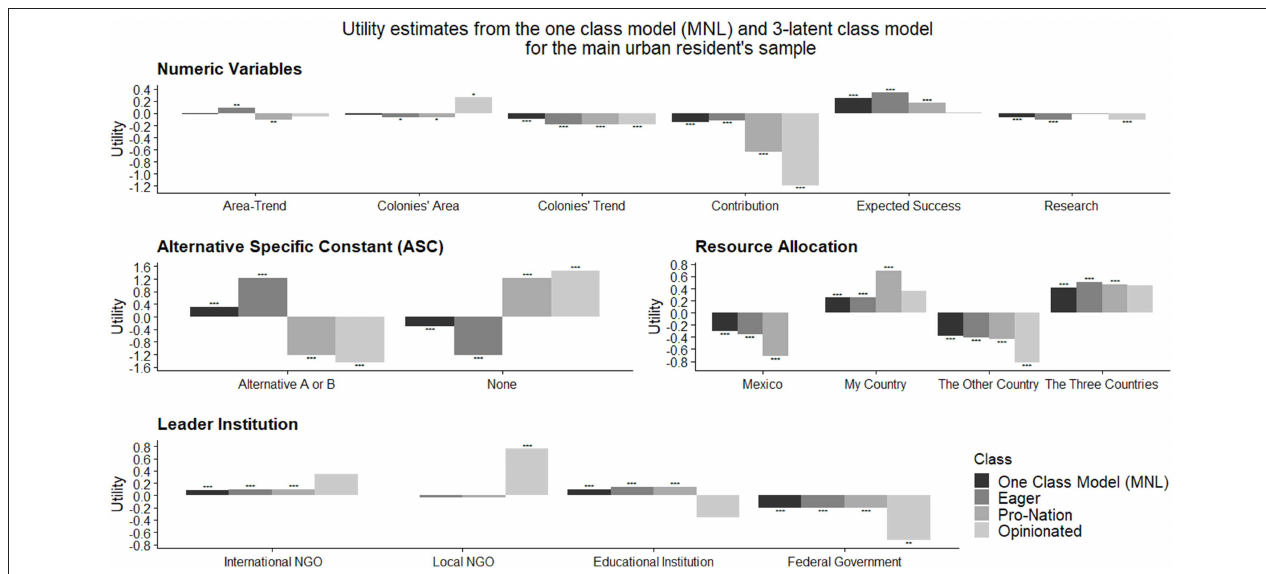
FIGURE 3 | Utility estimates for the one class model (MNL) and 3-latent class model for the main urban resident’s sample. The y-axis is a dimensionless representation of the utility derived from a specific level of an attribute. The Alternative Specific Constant (ASC) represents the willingness to support the program regardless of its configuration. ***1% significance level, **5% significance level, *10% significance level with two-tailed